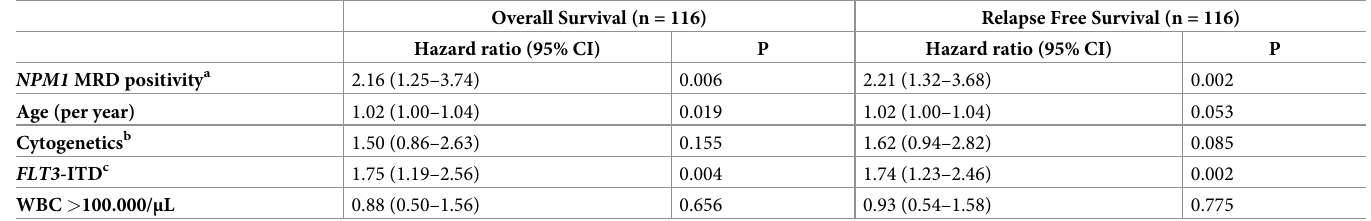
Table 1. Multivariate analysis of NPM1 MRD status after induction.